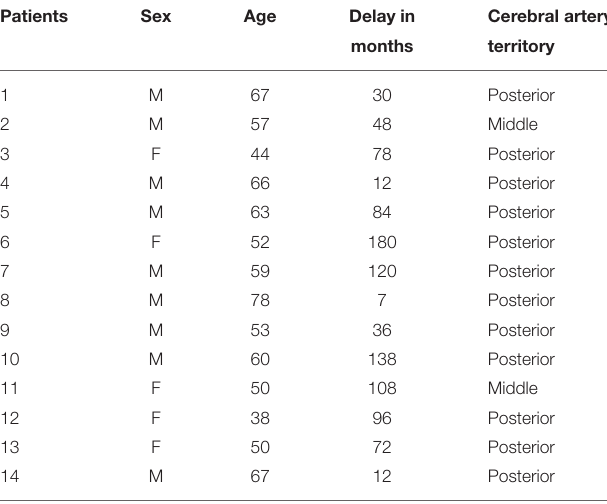
TABLE 2 | Clinical data of the patients.